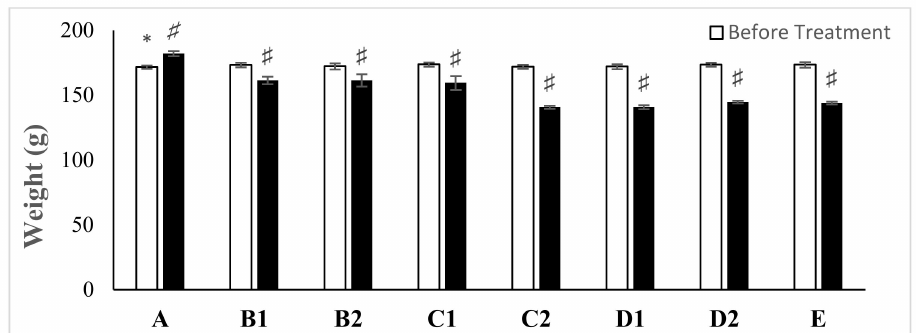
Figure 1. Mean body weight of experimental animals before and after oral administration of various concentrations of ZnO NPs Al. Data are presented as the mean ± SEM of at least n ≥ 5 replicate experiments and analyzed using one-way ANOVA followed by Newman–Keuls post hoc analysis.